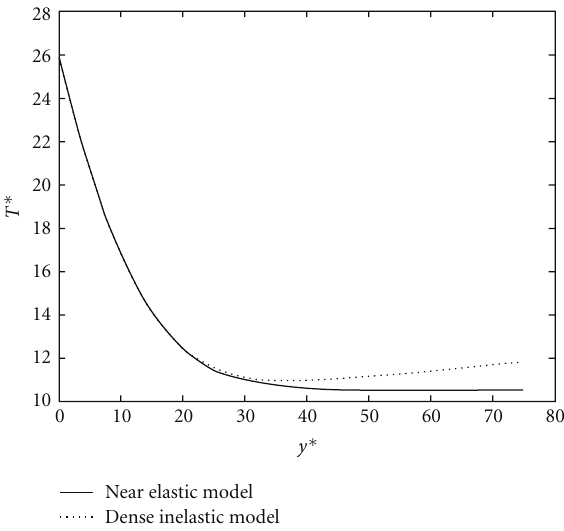
Figure 4: Comparison of granular temperature for near elastic model and dense inelastic models for V ∗ = 6 .